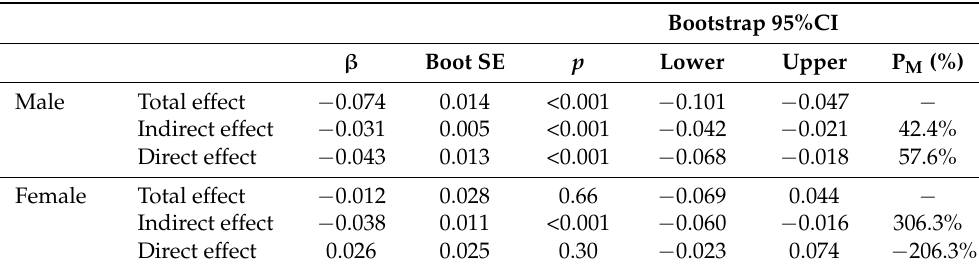
Table 3. Total, direct, and indirect effects of the mediation analyses investigating perceived stress as a mediator between physical activity and sleep